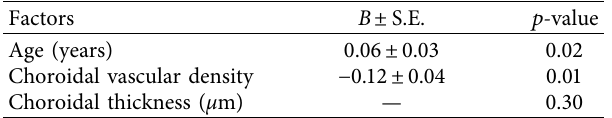
Table 2: Multivariate analysis for clinical characteristics for the included high myopia eyes with or without choroidal